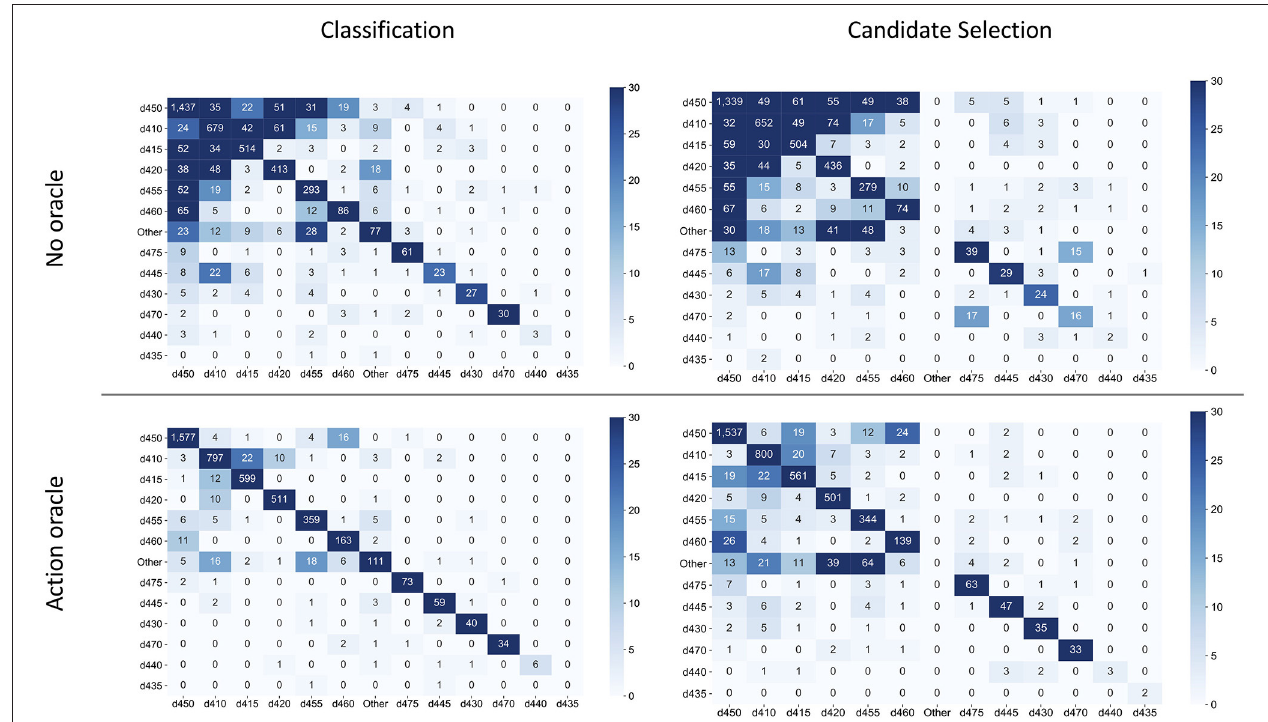
FIGURE 9 | Confusion matrices for best classification and candidate selection models, without access to the Action oracle (top row) and with oracle access (bottom row). The rows of each matrix indicate the annotated label for a sample, and columns indicate the predicted label. Labels are ordered from most frequent ( d450 ) to least frequent ( d435